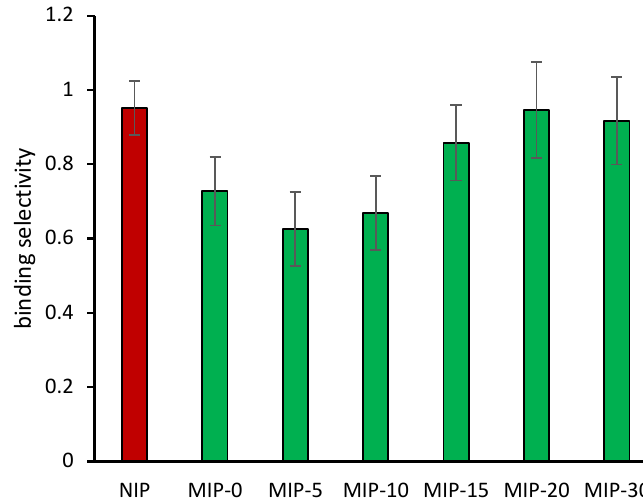
Figure 4. Binding selectivity ( ± standard error), calculated as the ratio between the equilibrium binding constants relative to mefenamic acid and diclofenac.